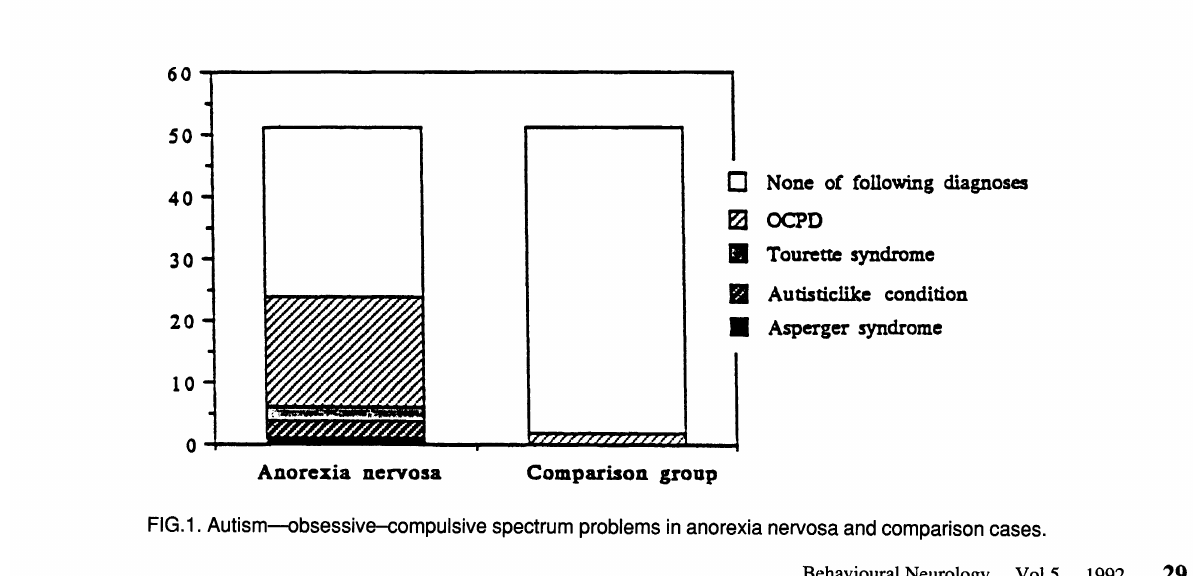
Behavioural Neurology. Vo15 .